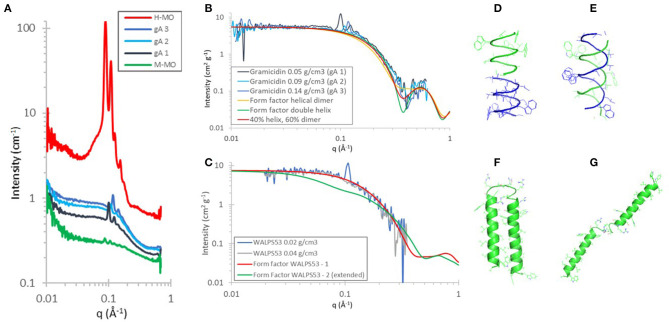
(A–C) SANS data showing H-MO and peptide encapsulation in 92% D-MO/8% H-MO (M-MO) at a range of peptide concentrations at 20°C in D2O. (A,B) Gramicidin A (1.9 kDa) concentrations reflect 1.6, 3.1, and 5.3 mol% with respect to MO and at 40% v/v D2O: diamond cubic QIID phase. (C) WALPS53 (5.9 kDa) at 0.2 and 0.4 mol% with respect to MO and at 35% v/v D2O: gyroid cubic QIIG phase. The SANS data was treated by first subtracting the MO cubic phase as background, then scaled to peptide concentration, and then a further incoherent background was subtracted. The calculated form factors were obtained using CRYSON. (D–G) were created using PyMOL and show cartoon representations of the secondary structures with side-chains shown as lines. They were obtained using PDB ID (D) 1MAG: helical dimer and (E) 1BDW: double helix. (F) WALPS53–1 dimer as generated using the iTasser server (Yang et al., 2015) and (G) WALPS53–2 (extended version of WALPS53–1).